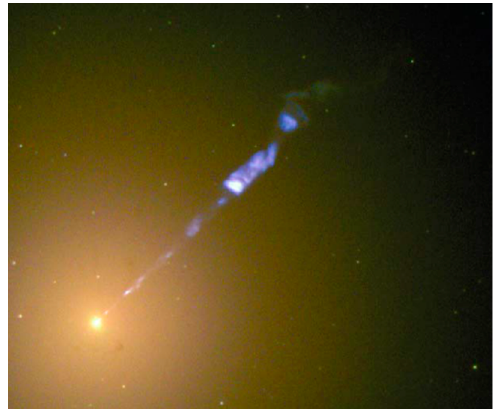
Figure 9. The radio jet of the elliptical galaxy M87 is also visible in the optical range. Detailed observations from the Hubble Space Telescope show various substructures, perfectly aligned from the central nucleus up to distances much greater than the size of the galaxy itself (© STSci/NASA).